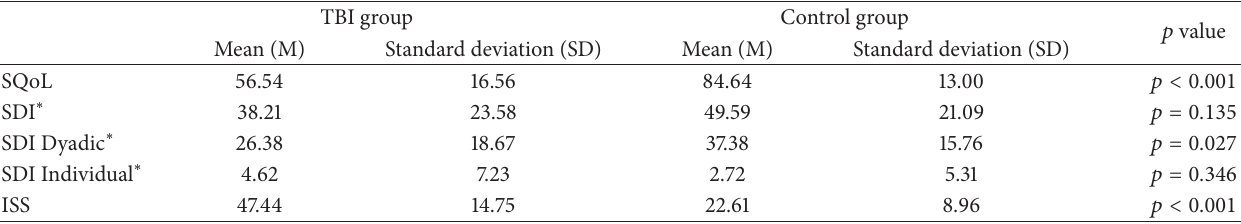
Table 2: Sexuality measure mean scores in the TBI ( 𝑛 = 29 ) and control ( 𝑛 = 29 ) groups and between-group differences. TBI